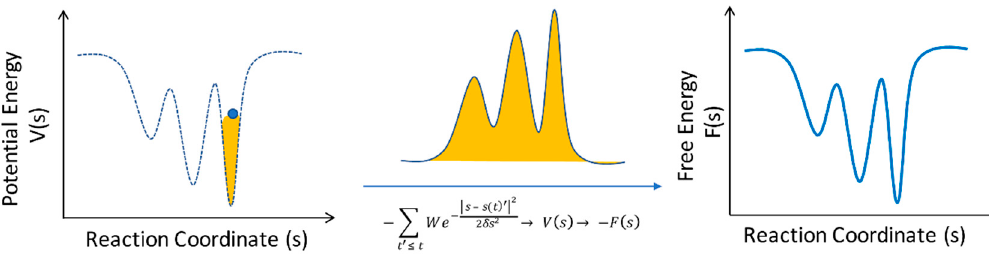
Figure 2. Filling a one-dimensional model potential with bias potentials, starting in the right local minimum. After filling up the local minimum, the system escapes to the other local minimum on the left and so forth, and generates the whole free energy landscape [39].